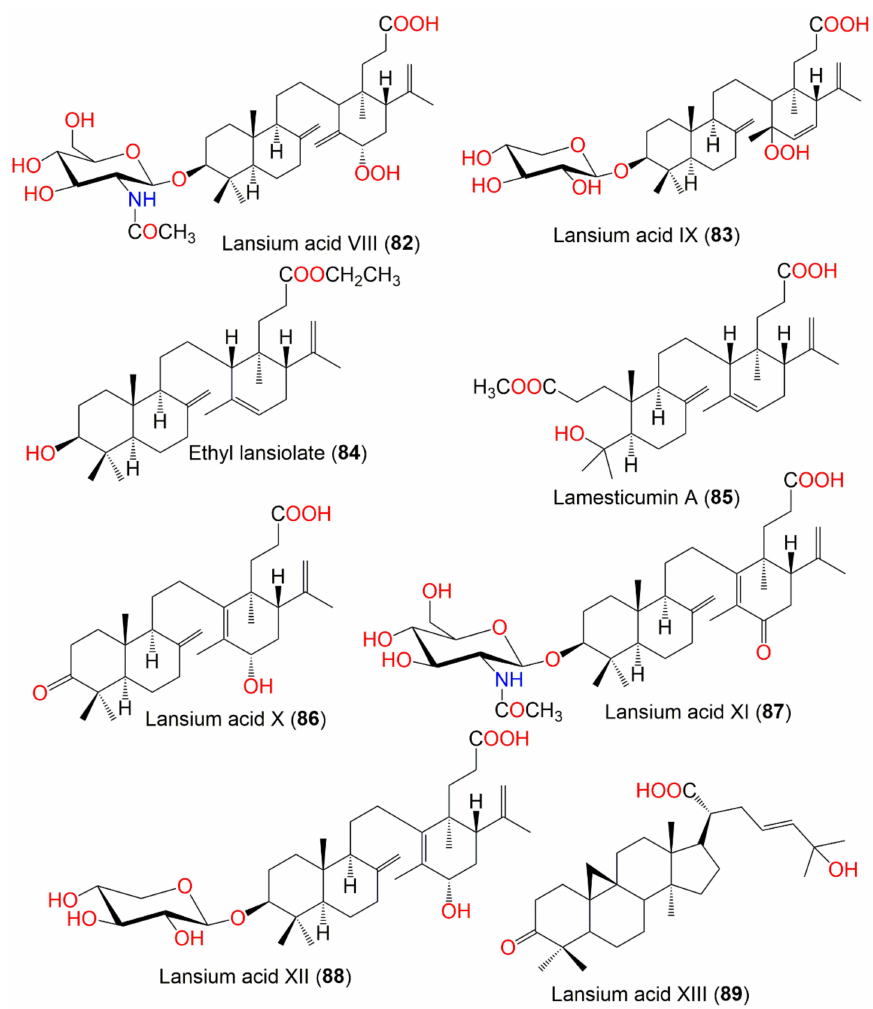
Figure 8. Structures of compounds 82 – 89 from Lansium domesticum